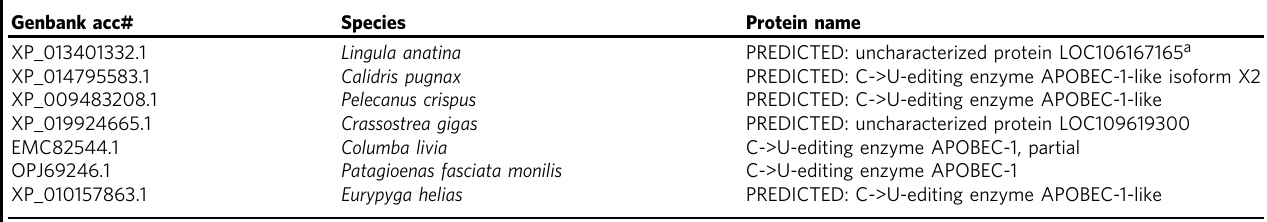
Table 2 Genbank entries with the highest similarity to LaAIDL2 (BLASTP) Genbank